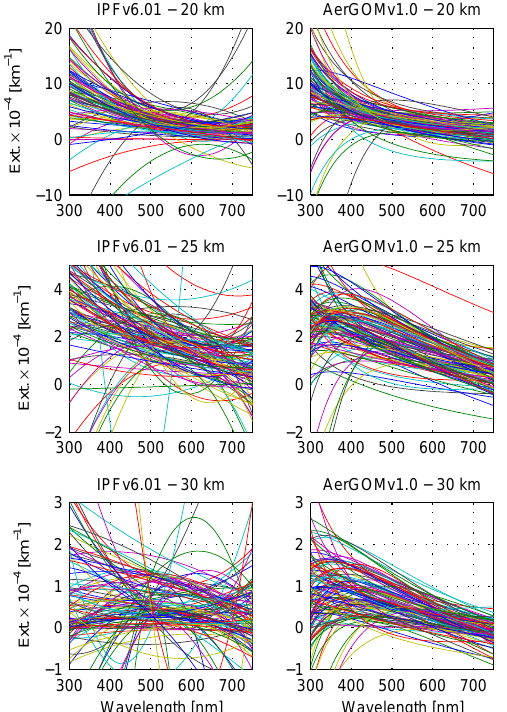
Figure 6. Aerosol extinction spectra at altitudes 20, 25 and 30km. The same data set as in Fig. 5 was used. Left column: IPFv6.01; right column: AerGOM